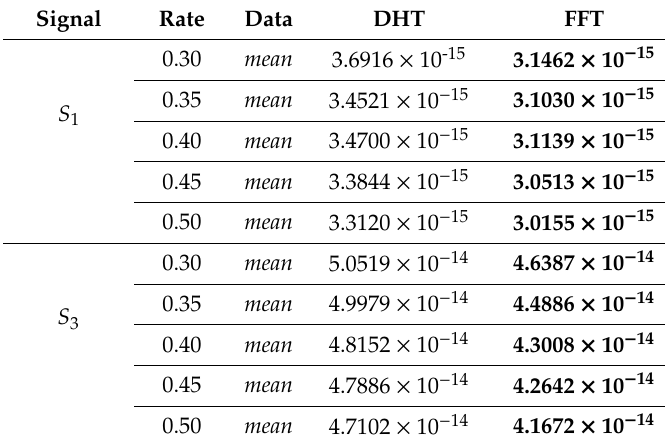
Table 3. Reconstruction e ff ect of di ff erent transform based on